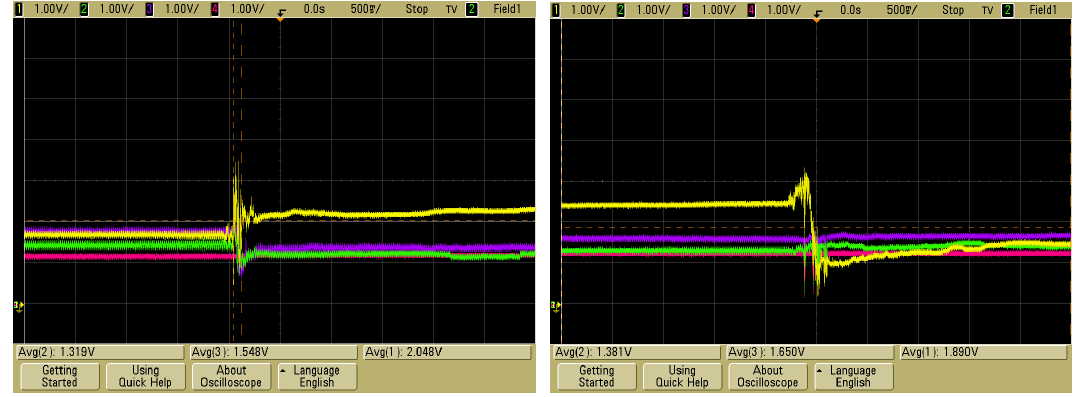
Figure 18. Application and removal of the weights.